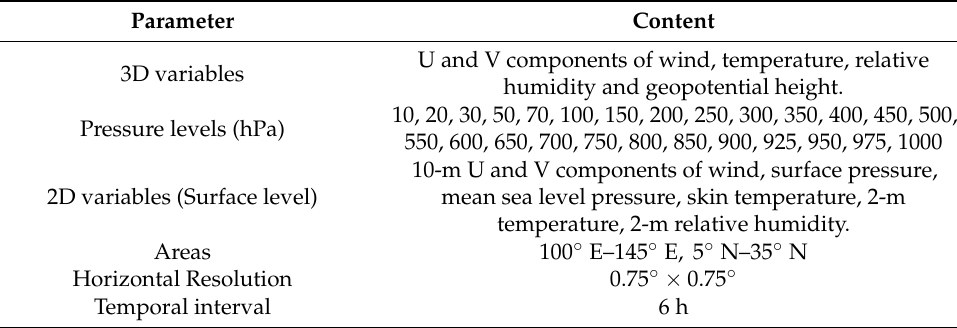
Table 1. Details of ECMWF historical reanalysis data. Parameter Content U and V components of wind, temperature, relative 3D variables humidity and geopotential height.